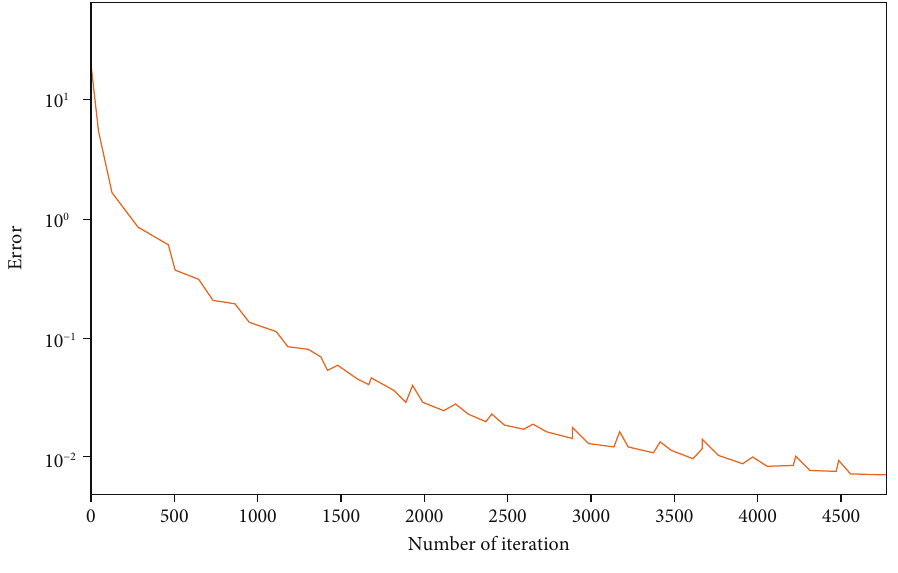
Figure 7: Usage error